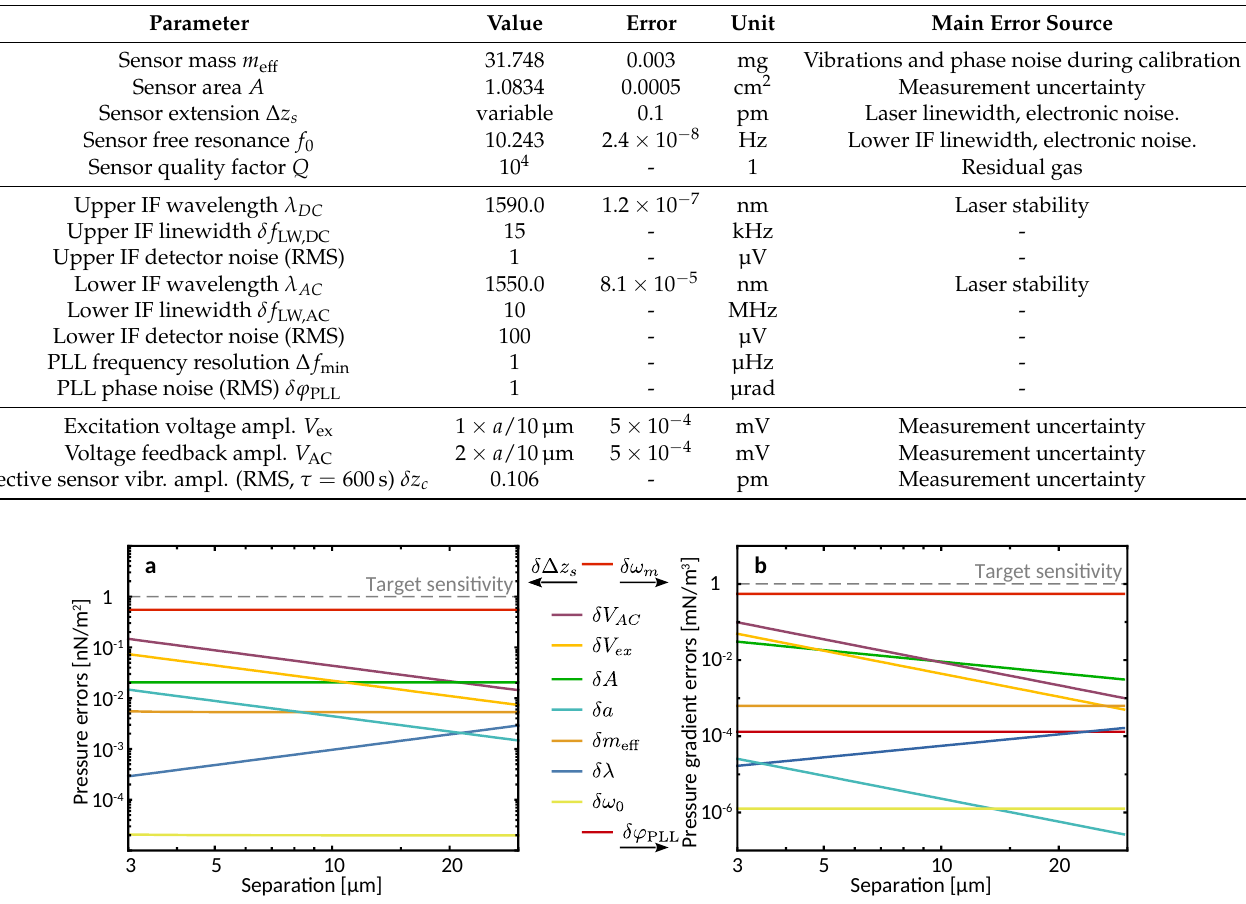
( b ). Additional det